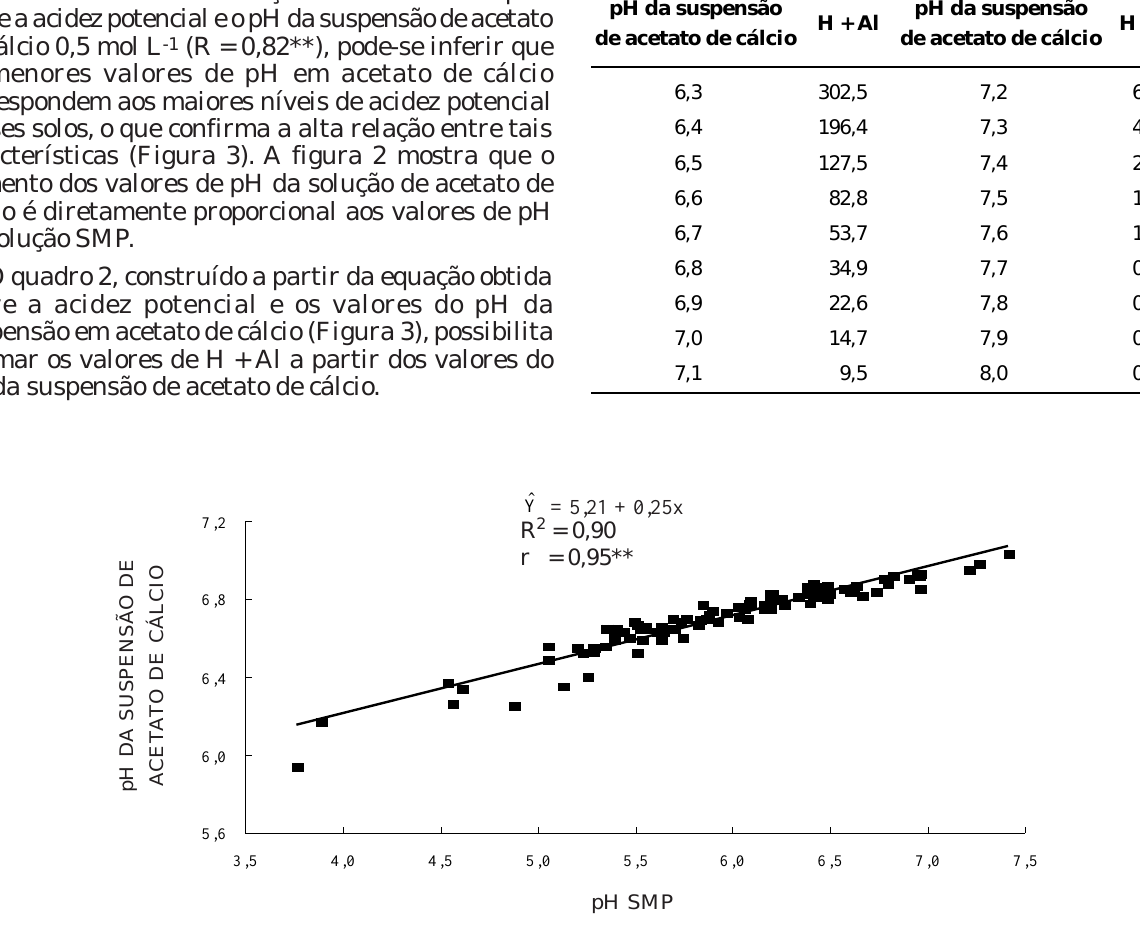
Figura 2. Relação entre o pH da suspensão de acetato de cálcio e o pH SMP.